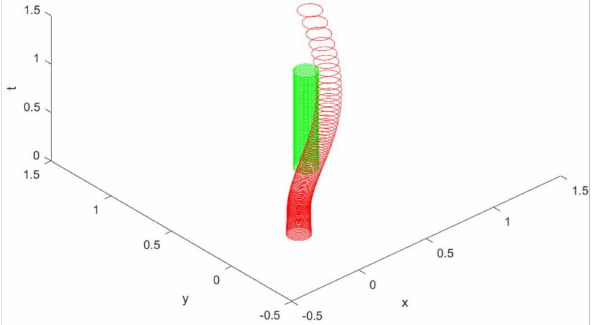
Figure 1. Elliptical tubes of trajectories for the E c [ t ] with no regard for the obstacle